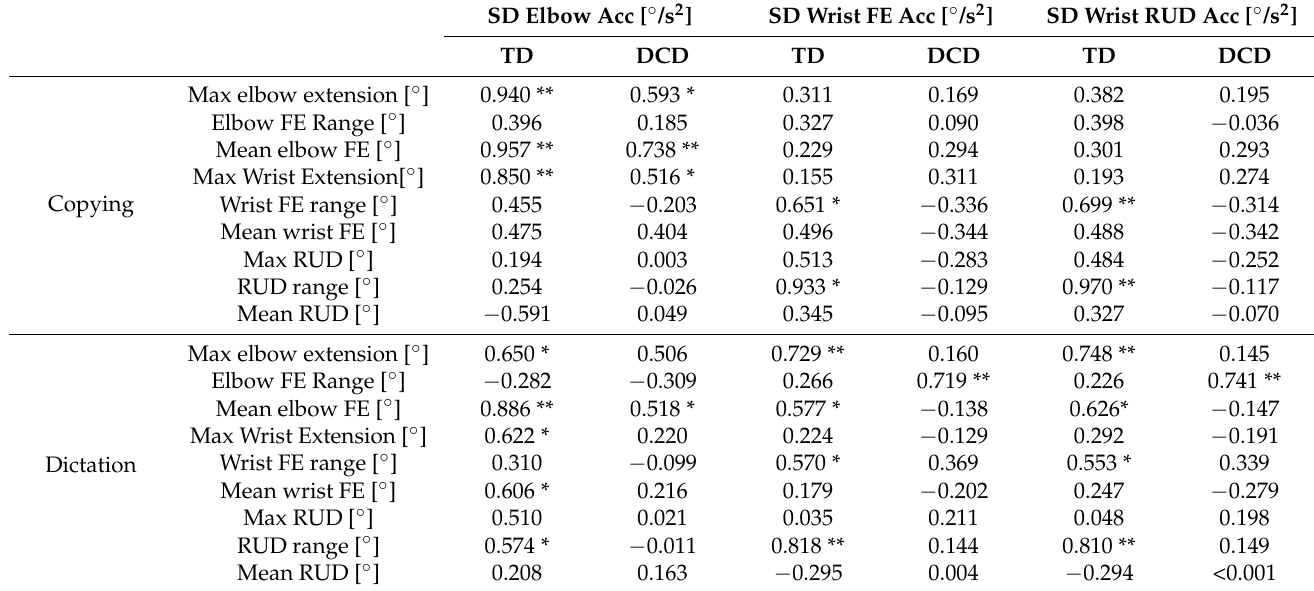
Table 6. Pearson (partial) correlations between handwriting postures and